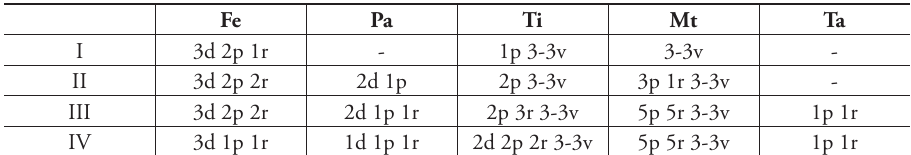
men black, with yellow spots and herringbone patterns. Epigyne as in Fig. 4: atrium with well delimited posterior margin, length subequal to width; copulatory openings indistinct, hidden by posterior margin of atrium; copulatory ducts long, about 2 times longer than diameter of receptacles; receptacles widely separated, subequal to diameter receptacles; hoods